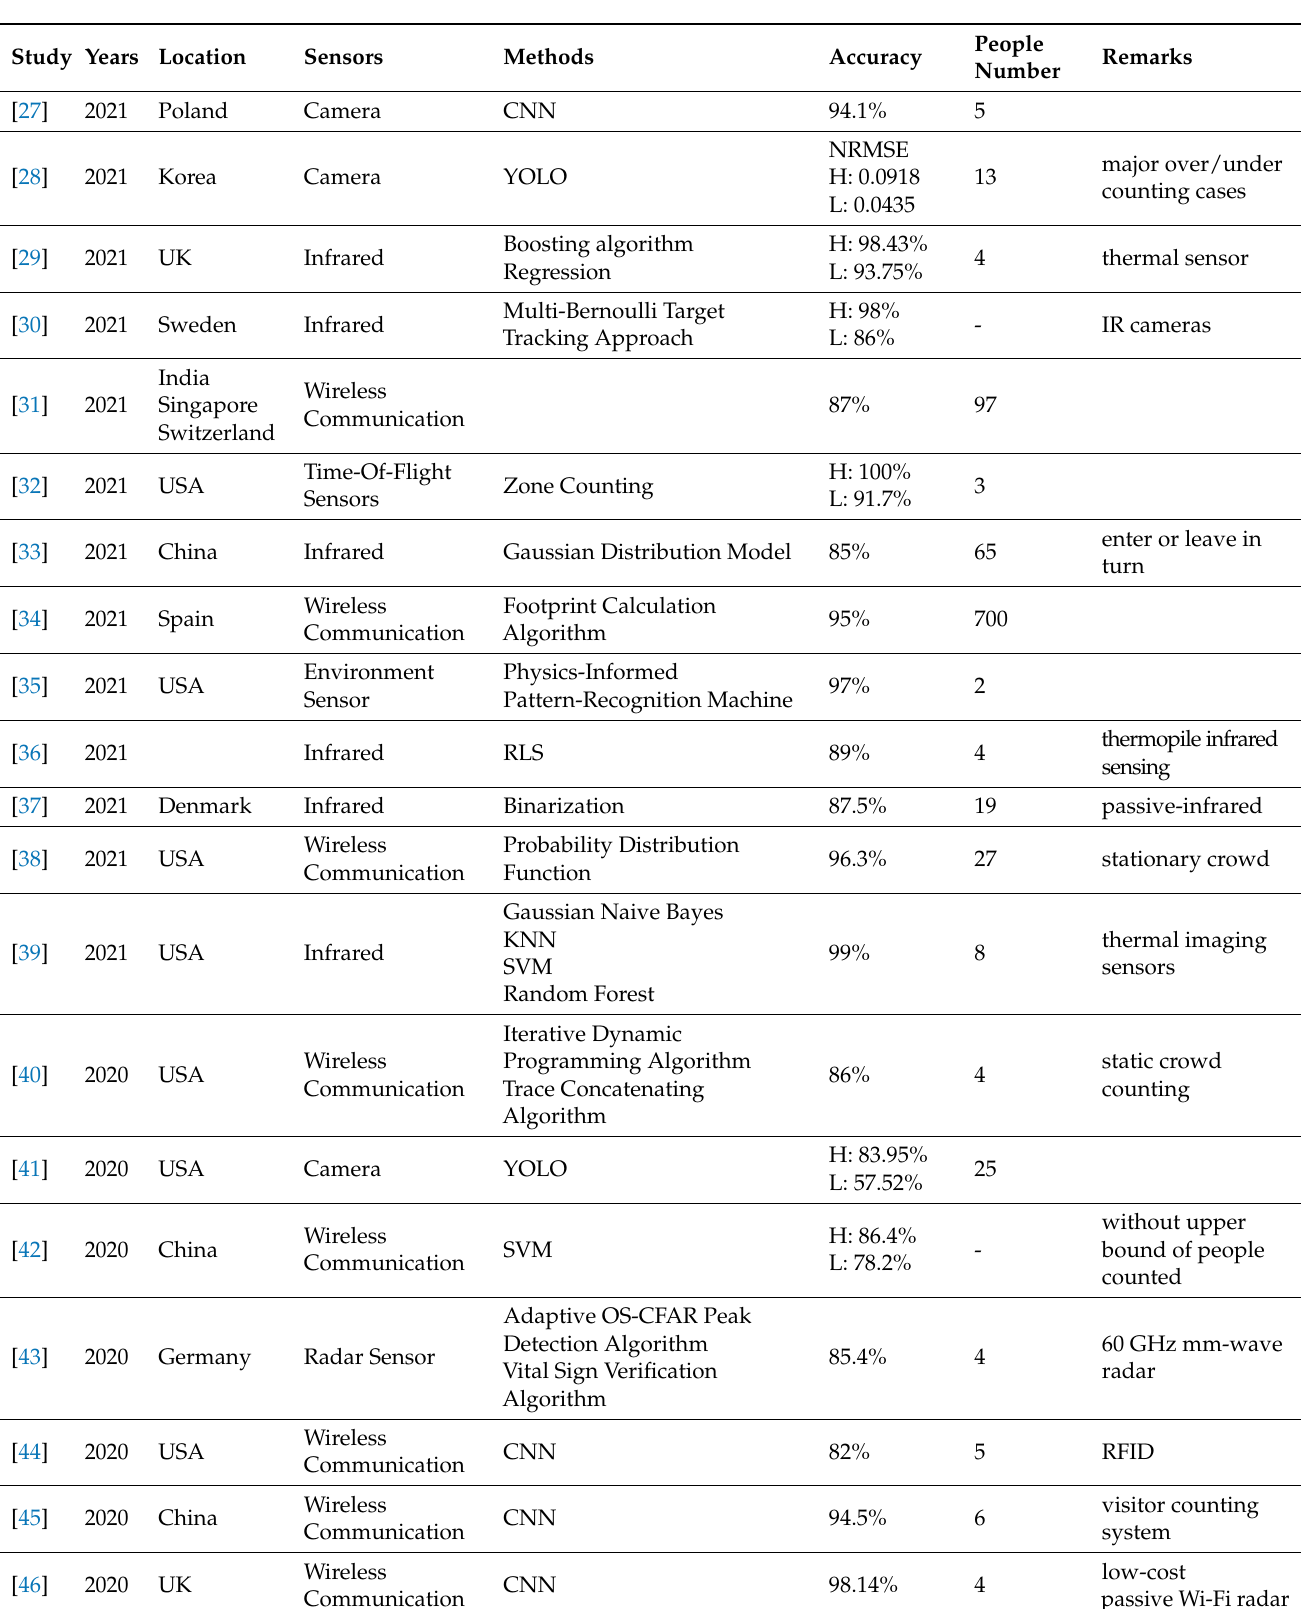
Table 1. The review results in detail in the chronological order of the literature